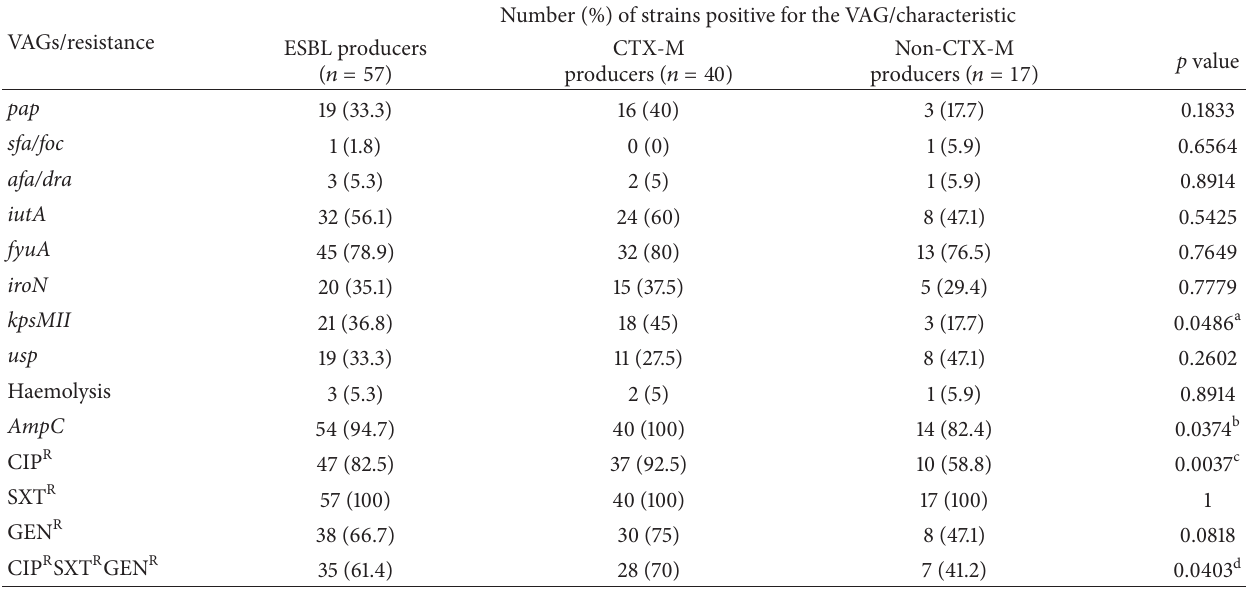
Table 1: VAGs/characteristics among the CTX-M producers ( 𝑛 = 40 ) and nonproducers ( 𝑛 = 17 ).